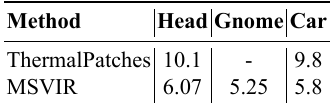
Table 2. Standard deviation of distances in mm for MVSIR and ThermalPatches dataset.